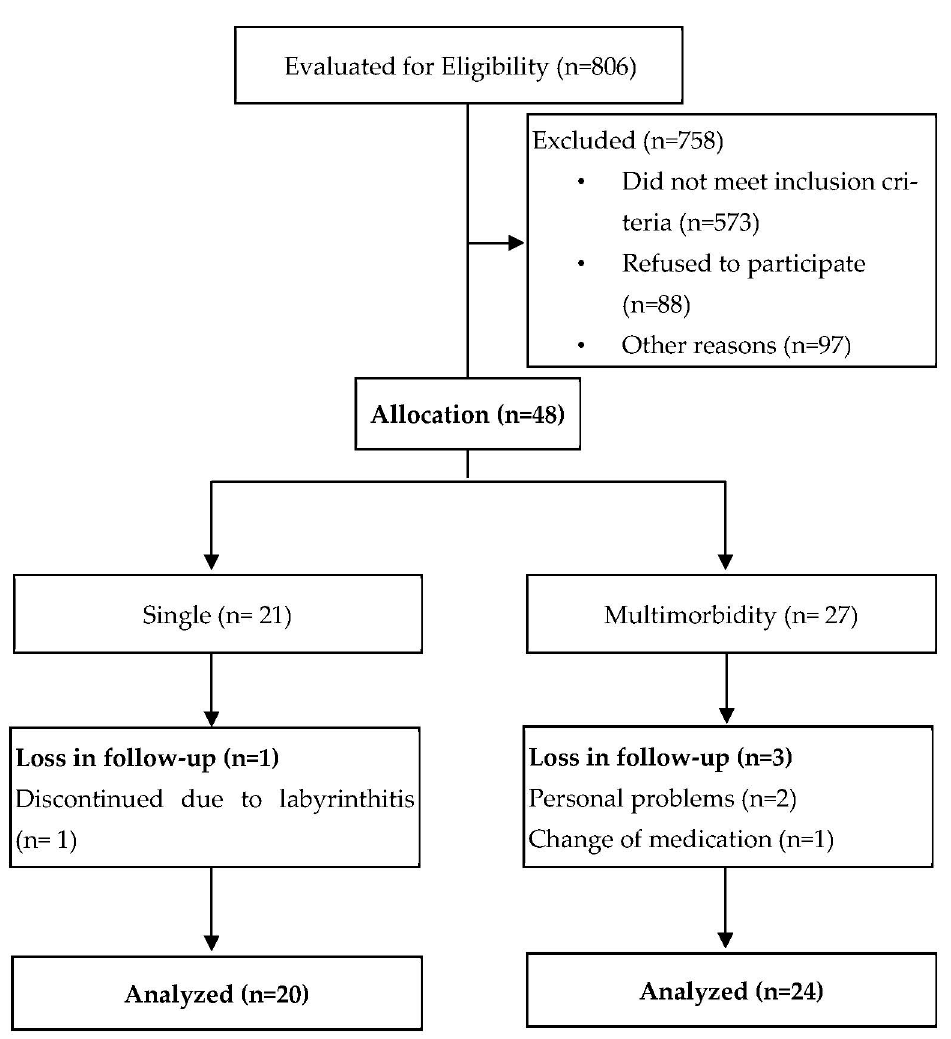
Figure 1. Follow-up flowchart.